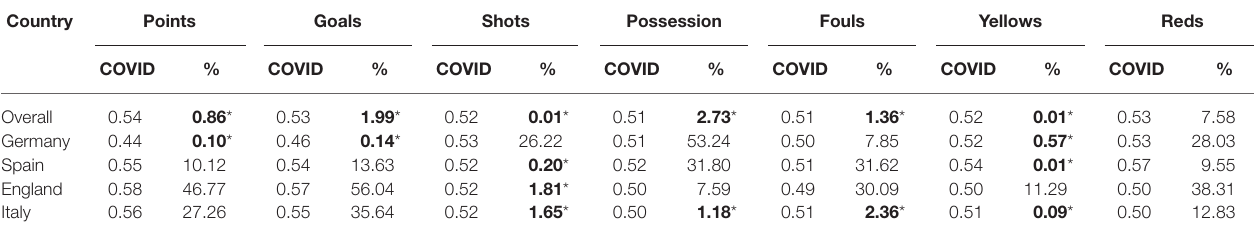
TABLE 1 | The results of the Monte Carlo permutation by country. Country